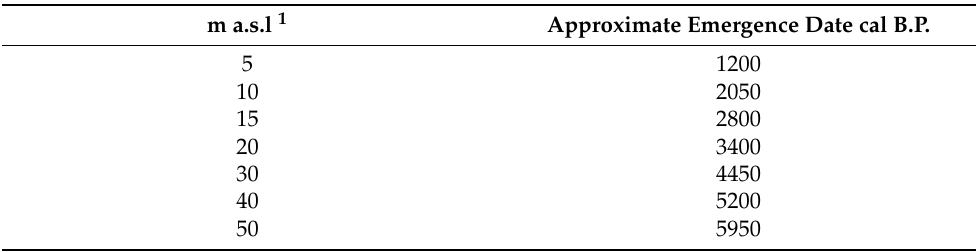
Table 4. Proposed dates that respective contour lines m a.s.l. emerged from marine waters based on Iqaluktuuq Relative Sea